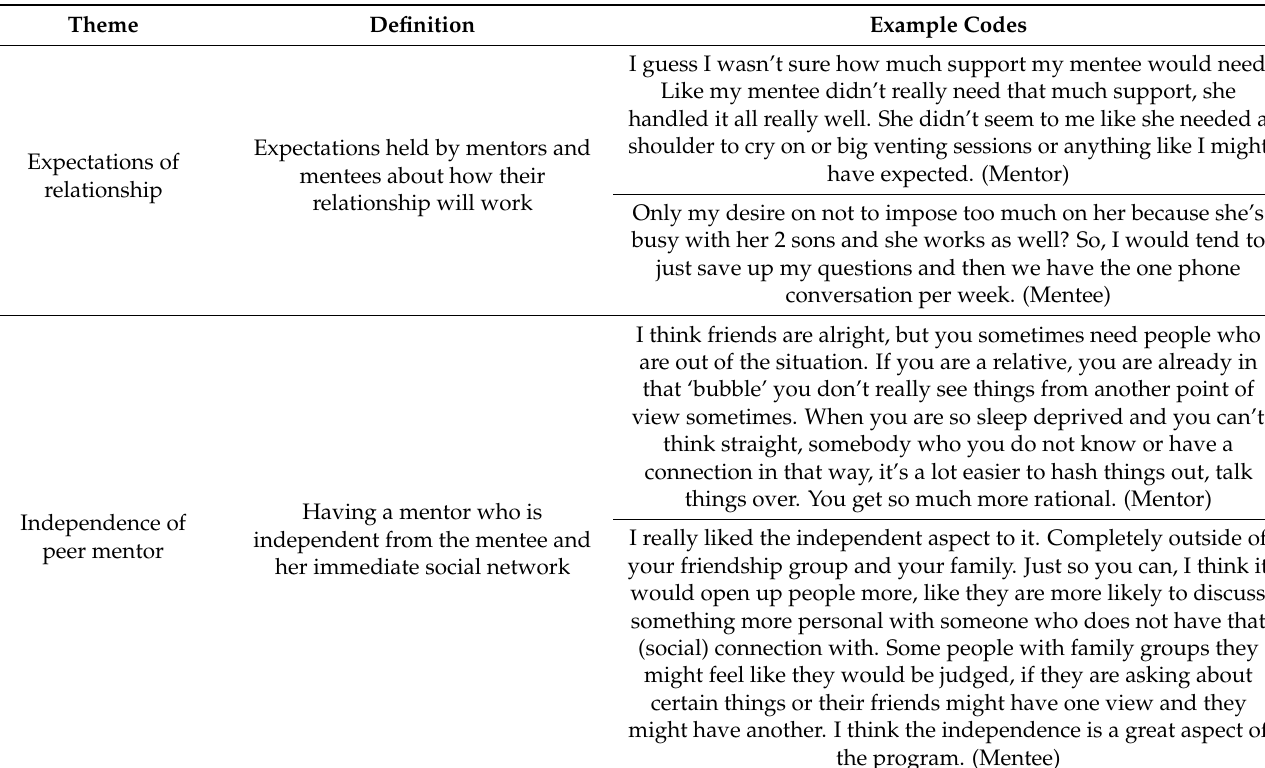
Table 1. Themes, definitions, and exemplar